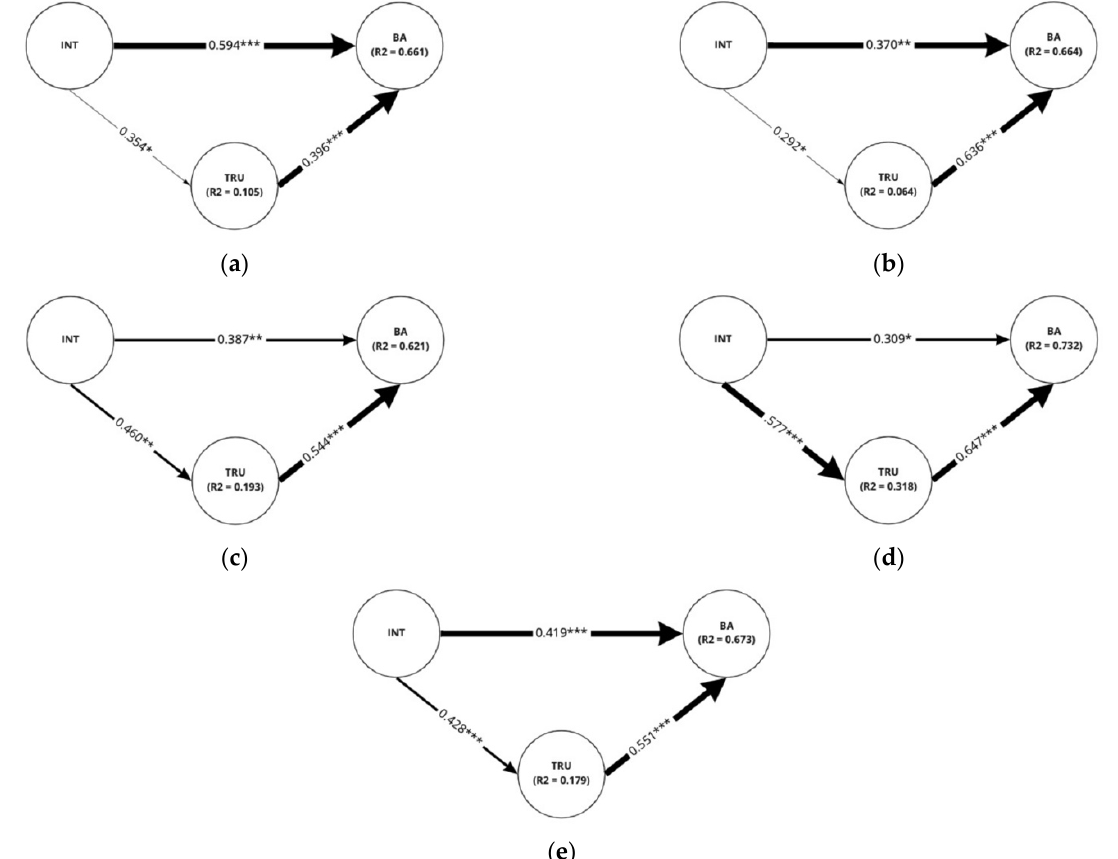
Figure 8. Pick-up service scenario: Results of analysis on each structural model for the application of eye movement and conversational distance ( a ) eye movement applied and conversational distance close; ( b ) eye movement unapplied and conversational distance far; ( c ) eye movement unapplied and conversational distance close; ( d ) eye movement applied and conversational distance far; ( e ) full sample for the scenario. INT: Intimacy, TRU: Trust, BA: brand attitude. * R 2 values indicated in the figures are adjusted values of R 2 . * p < 0.05, ** p < 0.01, *** p < 0.001. Table 5. Multi group analysis for pick-up service scenario 1 (N = 45).